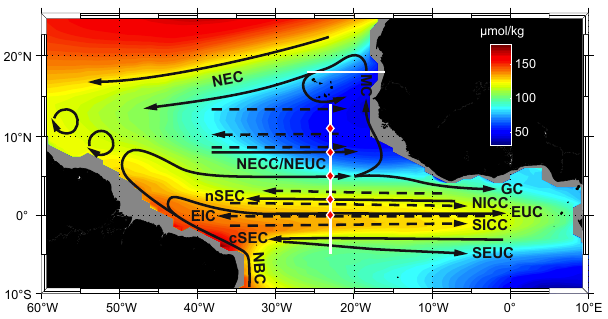
Figure 1. Oxygen concentration (µmolkg − 1 ) in the tropical At- lantic at σ θ = 27 . 1kgm − 3 (close to the deep oxygen minimum) as obtained from the MIMOC climatology (Schmidtko et al., 2013) with circulation schematic superimposed. Surface and thermocline current branches shown (black solid arrows) are the North Equa- torial Current (NEC), the Mauritania Current (MC), the northern and central branches of the South Equatorial Current (nSEC and cSEC), the North Equatorial Countercurrent (NECC), the Guinea Current (GC), the North Brazil Current (NBC), the North and South Equatorial undercurrents (NEUC and SEUC), and the Equatorial Undercurrent (EUC). Intermediate current branches shown (black dashed arrows) are the North and South Intermediate countercur- rents (NICC and SICC) or “flanking jets”, and the Equatorial In- termediate Current (EIC). The 23 ◦ W and 18 ◦ N repeat sections are marked by white lines, mooring positions by red diamonds.